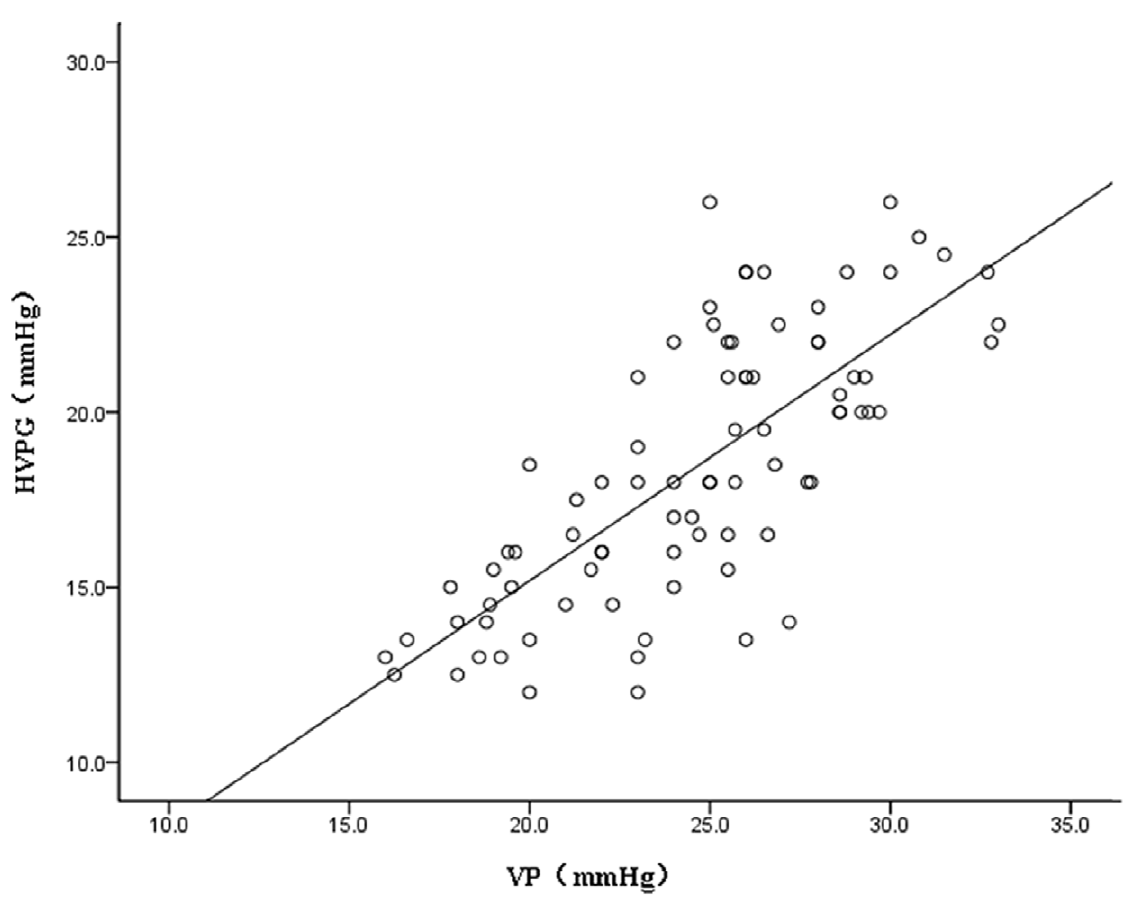
Figure 4. Correlation between the HVPG and the VP measured by CEBM in 83 patients with cirrhosis and esophageal varices.